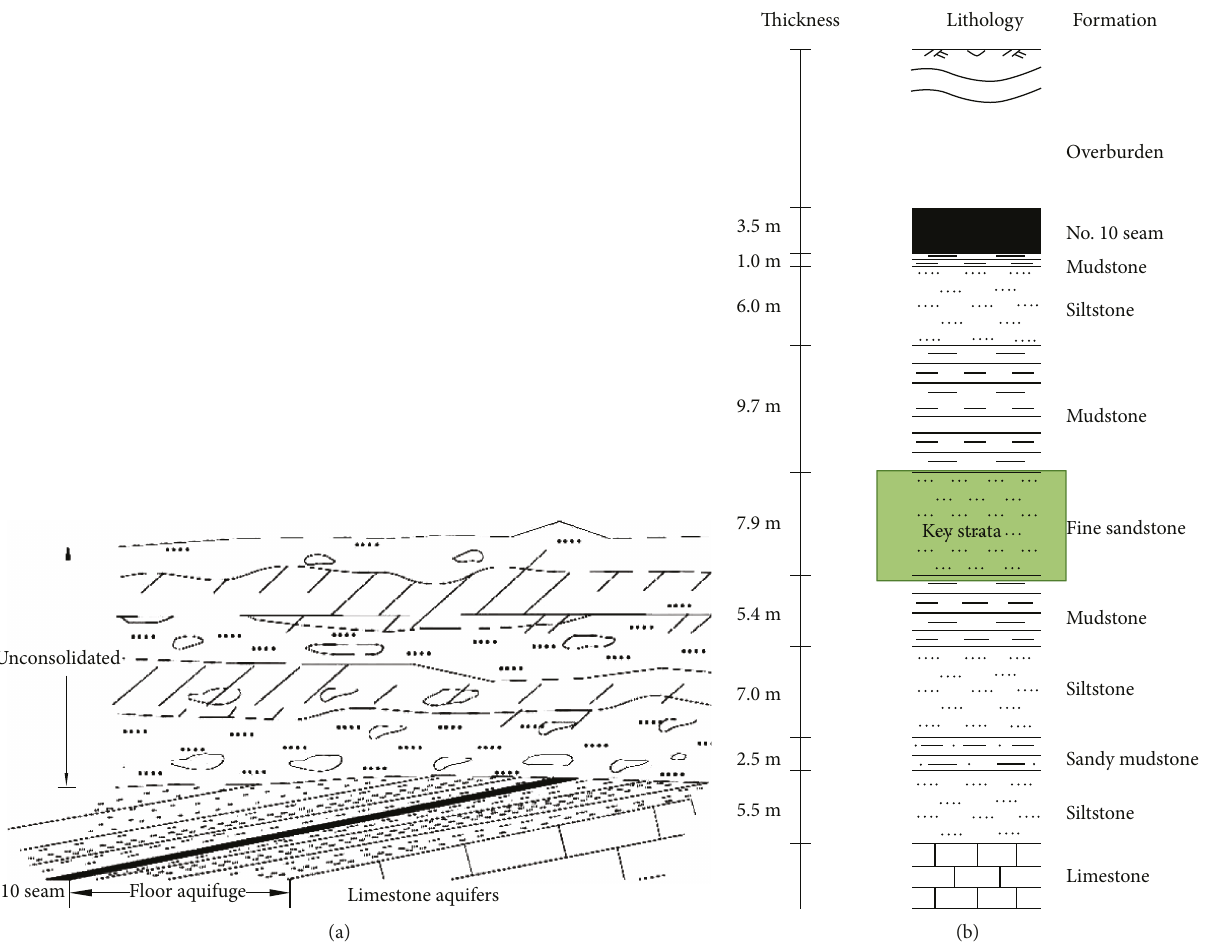
Figure 10: Sketch map of the 10-coal seam pro fi le and histogram of the water-resistant fl oor. (a) Sketch map of the 10-coal seam pro fi le and (b) histogram of the water-resistant fl